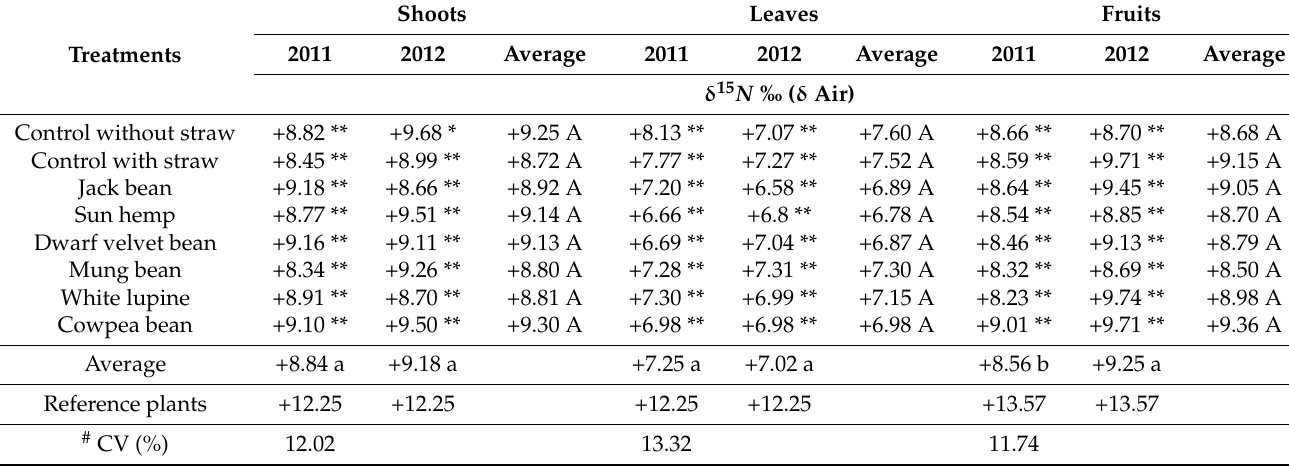
Table 8. N concentration of shoots, leaves, and fruits of cherry tomato intercrop with legumes in the field. Shoots Leaves Fruits 2011 Average Average Average Treatments Control without straw Control with straw Jack bean Sun hemp Dwarf velvet bean Mung bean White